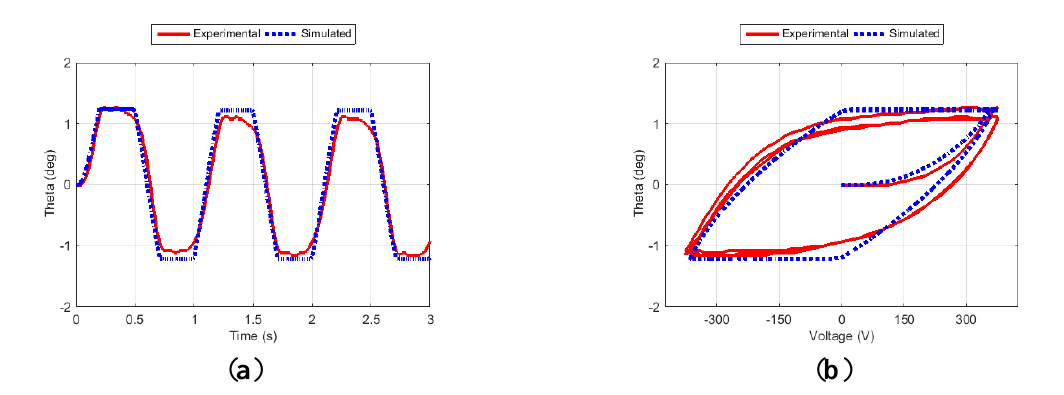
Figure 11. Fin angle ( a ) and hysteresis curve ( b ) for Case 3.